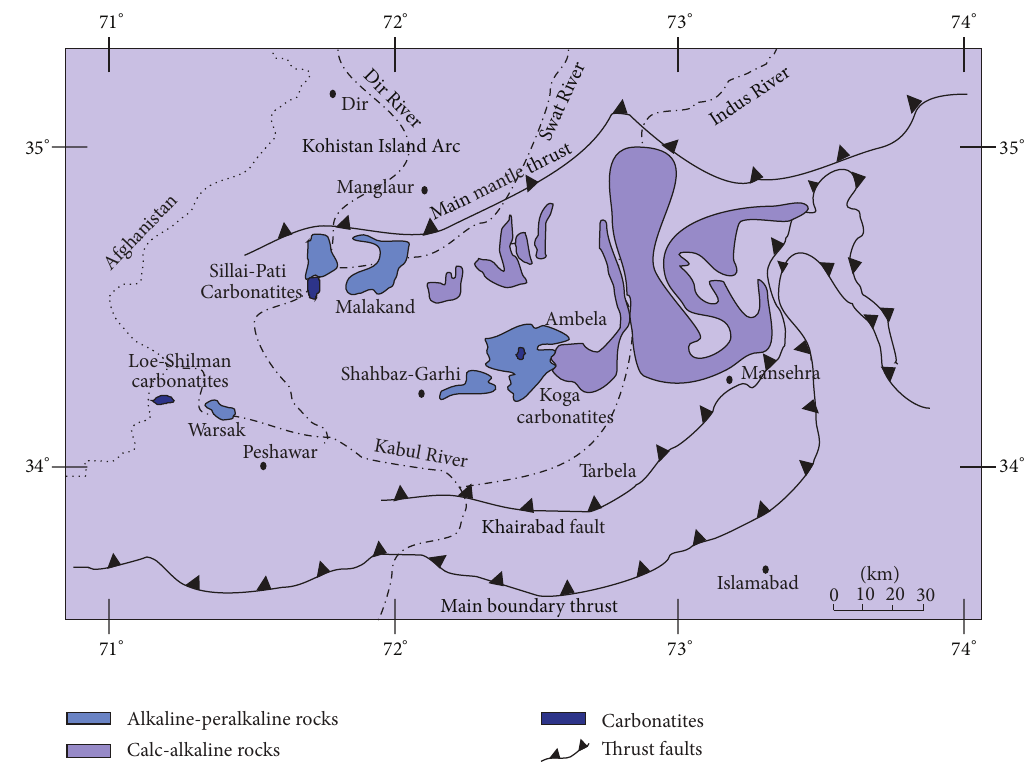
Figure 1: Generalized geological map showing the location of alkaline rocks in northern Pakistan; redrawn from Khattak et al. [22].